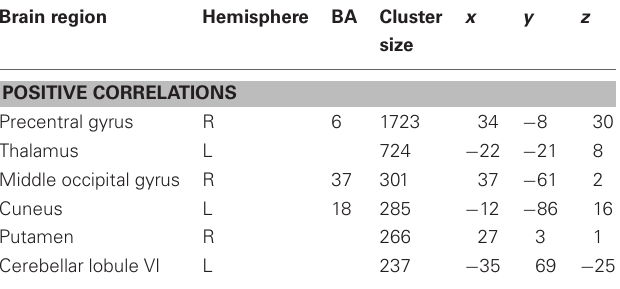
Table 3 | Regional activation for correlational analysis for sequence-specific weighted image for temporal precision difference score (mean repeated − mean random) at